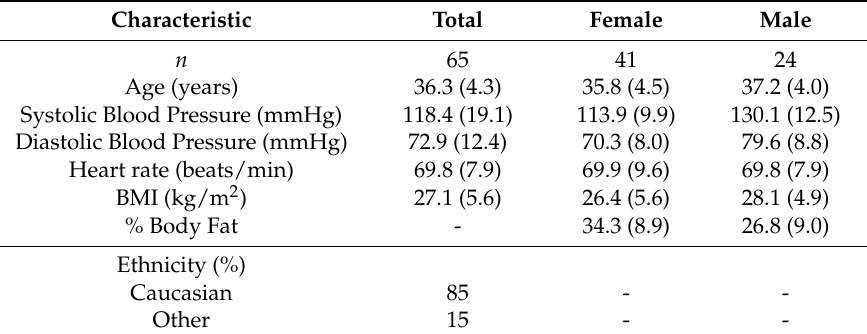
Table 2. Adult participant characteristics in total and separated by sex.